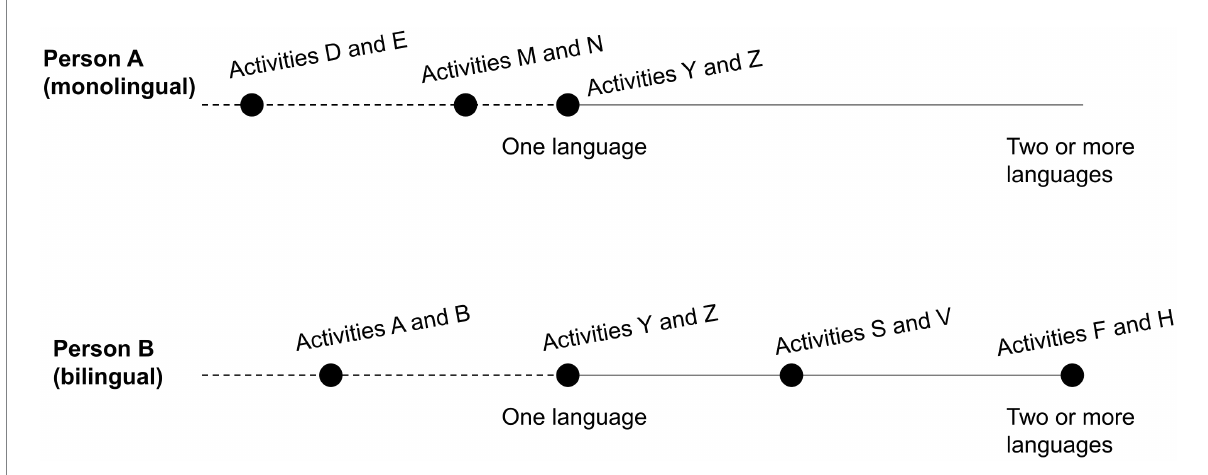
FIGURE 4 There’s no such thing as literal “full proficiency”: as language skills are grounded in activities, there are always going to be activities for which anyone (whether monolingual or bilingual to some degree) lacks proficiency. To illustrate this, in contrast to the previous figures, here we add space to the left of “One Language” to capture how some activities fall outside the range of an individual’s linguistic repertoire (dotted